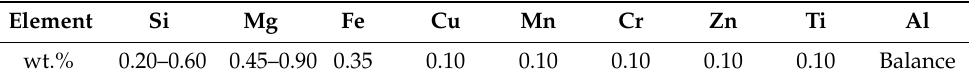
Table 1. Chemical composition of 6063 aluminum alloy (in wt.%). Figure 1. Metallographic structure of 65 vol.% aluminum matrix composites reinforced with SiC particles (SiC p /6063 Al MMCs).